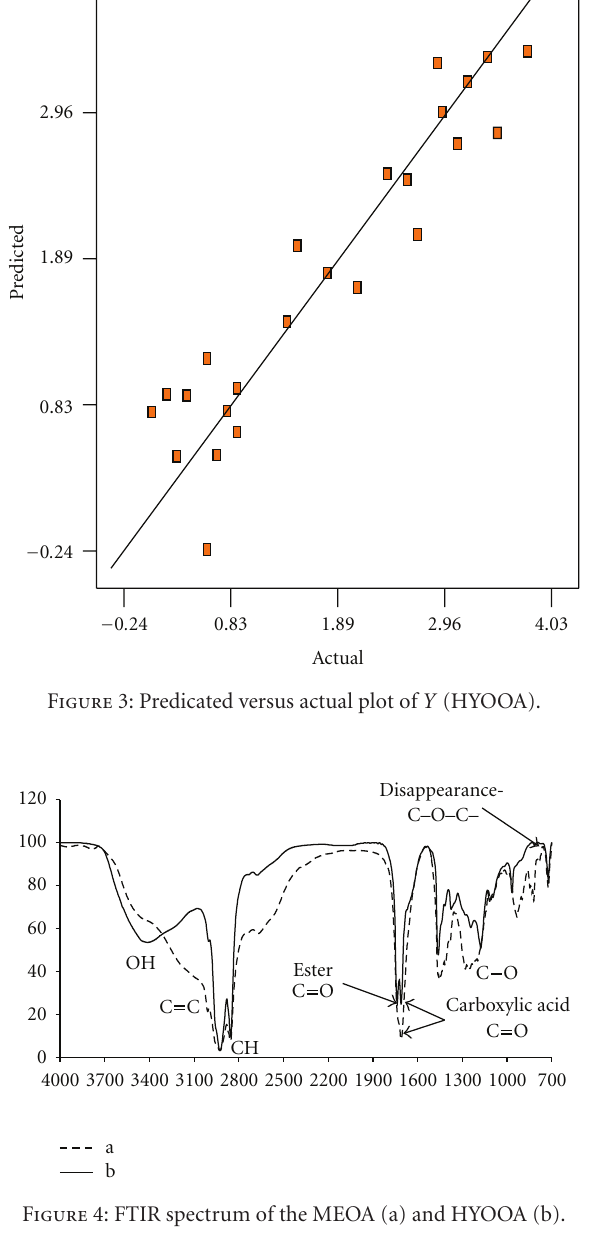
Figure 4: FTIR spectrum of the MEOA (a) and HYOOA (b).